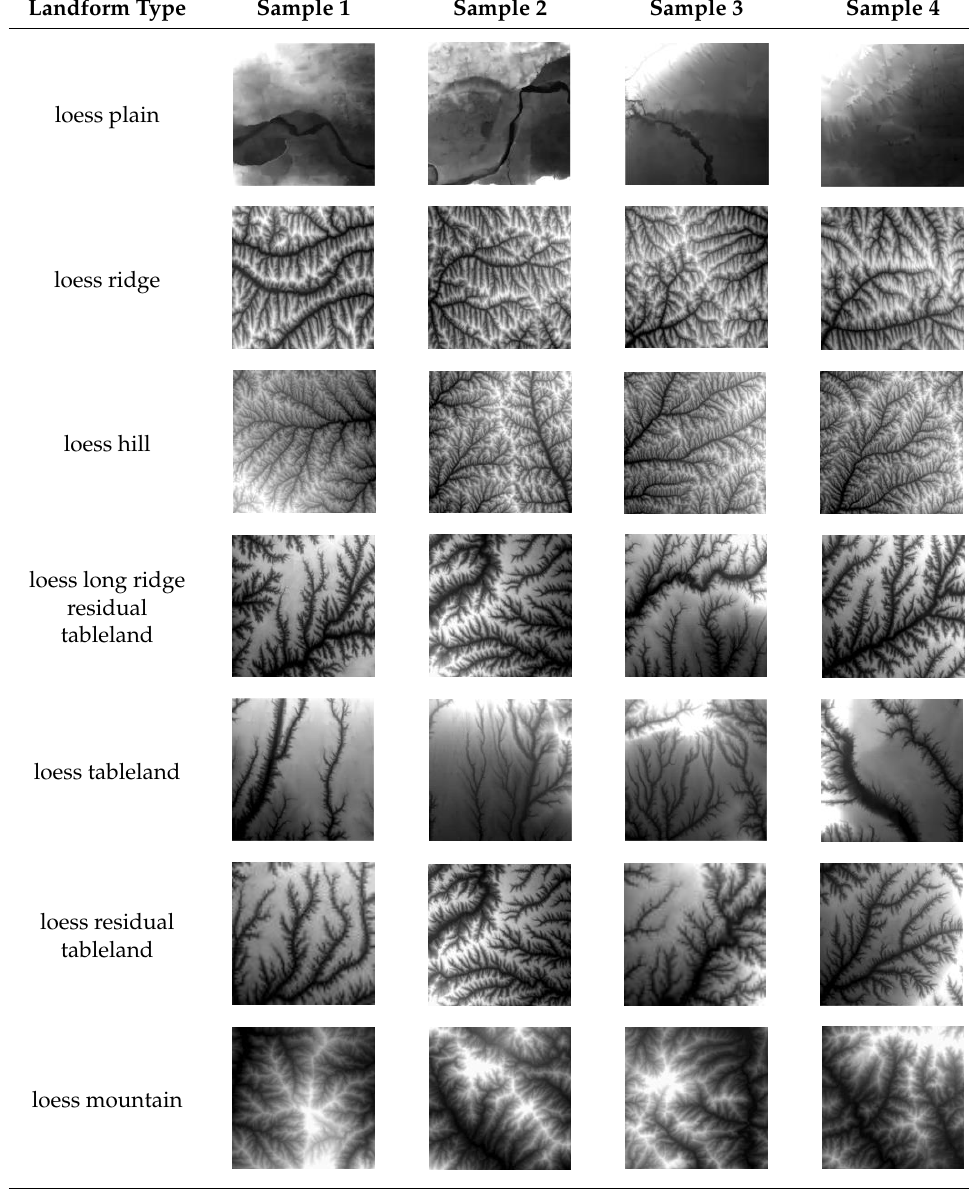
Table 1. Training samples of typical landforms.